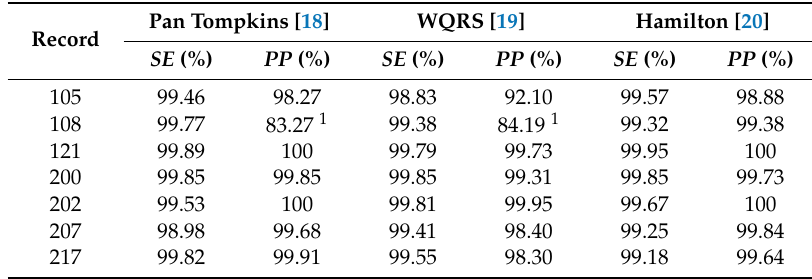
Table 2. Comparison of the beat detector performances for ECG records 105, 108, 121, 200, 202, 207 and 217.